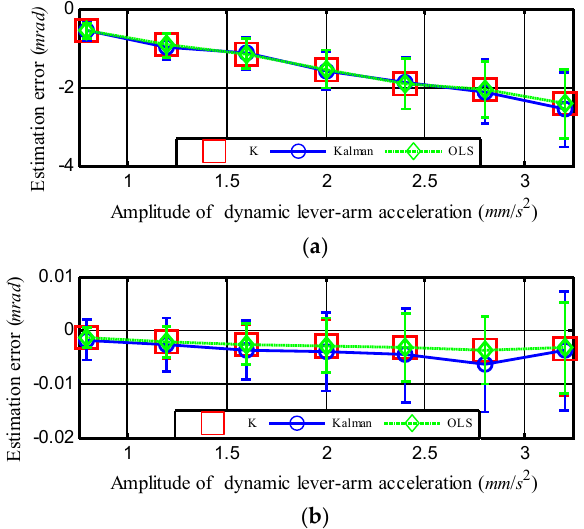
.. m r  . Error for r m dy . Error for the dy